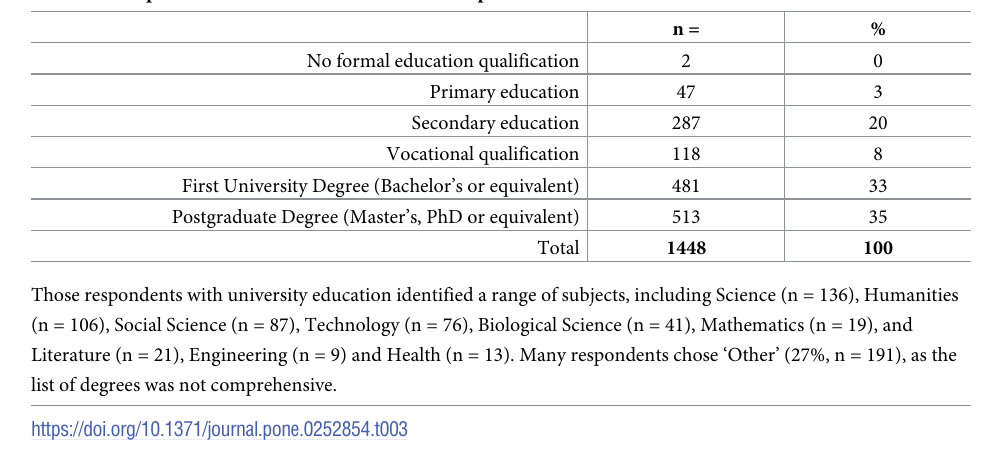
More specifically, ERN attendees in the sample across all years and countries have shown